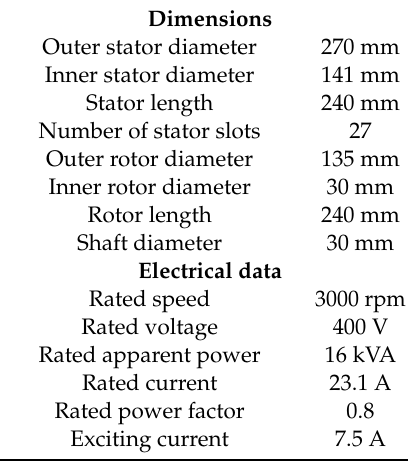
Table 4. Geometric and electrical parameters of the 16-kVA generator used in the ANSYS Maxwell.